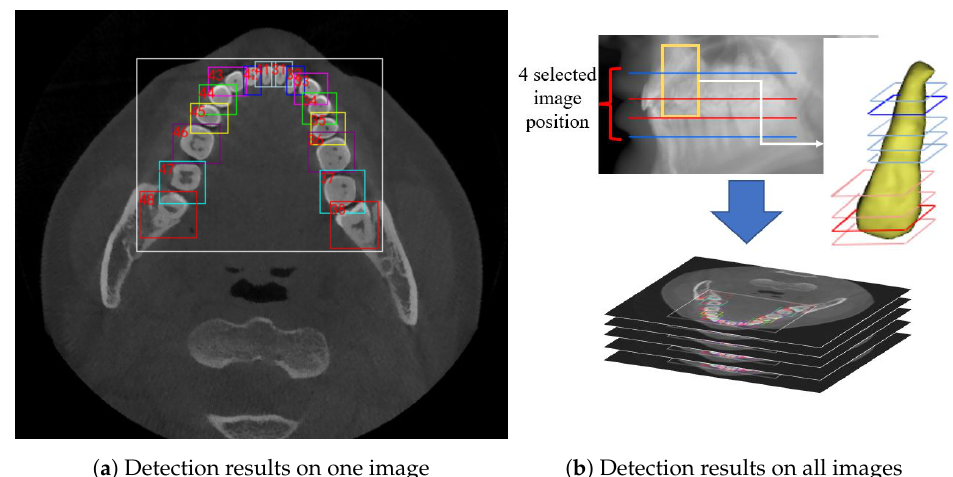
Figure 5. ( a ) shows final detection result on a CBCT image after finishing the whole teeth detection procedure; ( b ) shows how we get tooth bounding boxes in all images: selected layer images use our detection method and detect several sets of tooth bounding boxes (red and blue ones). Then, neighboring images share these